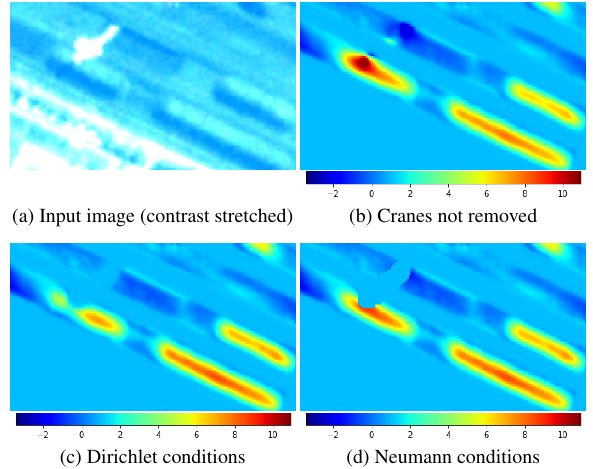
Figure 3. The necessity of mixed boundary conditions. The cranes seen in (a) violate the constant albedo hypothesis which results in an erroneous reconstruction (b). The result in (c) is obtained by imposing a Dirichlet condition everywhere and in particular along the occluding objects boundaries, which affects the estimation of the occluded stockpile. The result in (d) is uses Neumann conditions along the occluding objects boundaries resulting in better